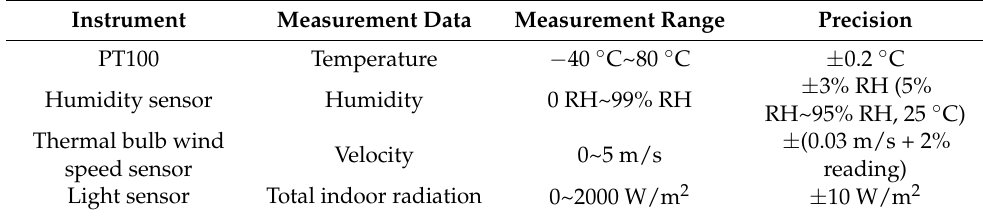
Figure 1. Greenhouse cross-section diagram. Table 1. Sensor Specifications.